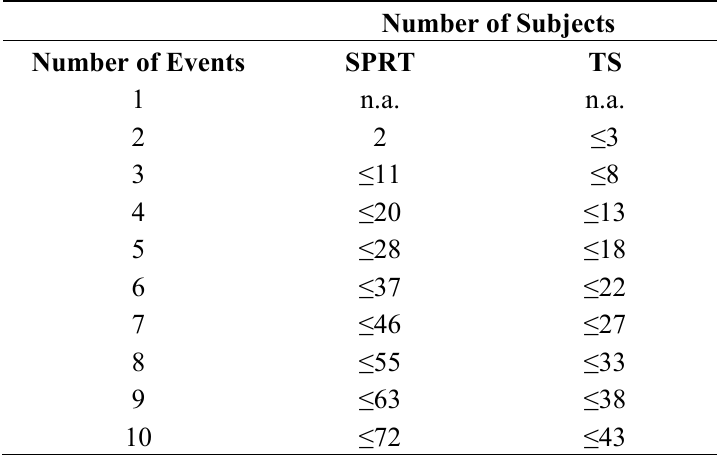
Table 1. Safety Boundary Using Blinded Data.